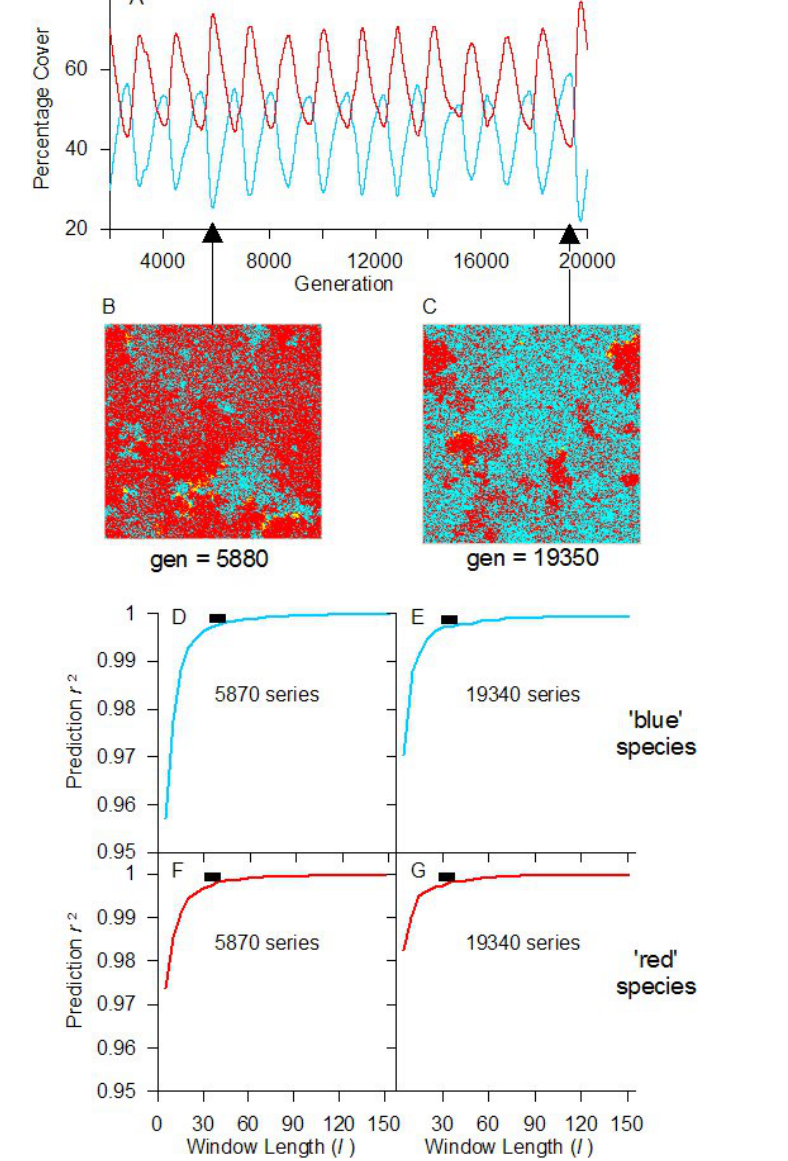
Fig. 1. Dynamics of a three-species system (A) demonstrating a stationary attractor but characterized by strong oscillations of the two dominant species (S and S ). Even though the landscape at different red blue times might be dominated by either S (B = landscape at 5880 generations) or S (C = landscape at red blue 19 350 generations), prediction-r 2 spectra derived from analysis of landscapes at these two times, whether based on S (D and E) or S (F and G), show similar estimates of the CLS at about 35 length blue red units (areas identifying the CLS are shown as black horizontal bars). These analyses were based on abundances (densities) in sequences of five maps commencing at either generation 5870 or 19 340, with 10 time steps between consecutive